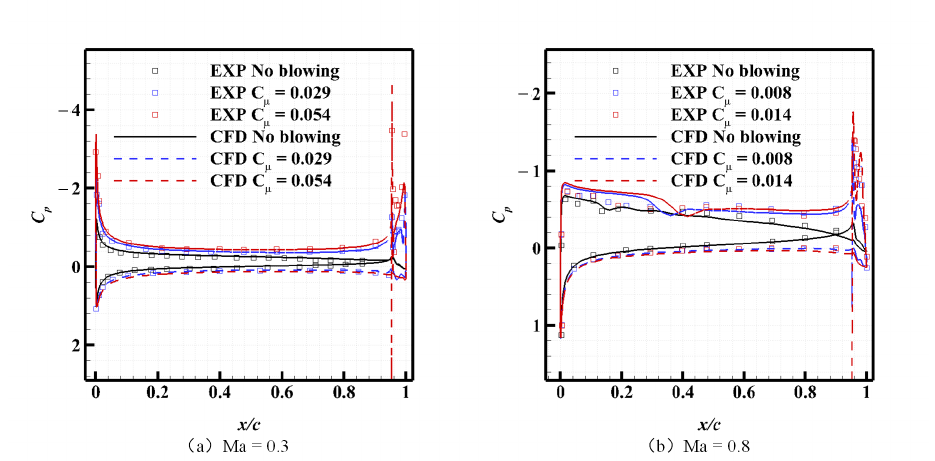
Figure 5. Comparisons of pressure coefficients under upper slot blowing ( Ma = 0.3 and 0.8 at α = 3 ◦ ). The results for the case without slot blowing are also depicted.